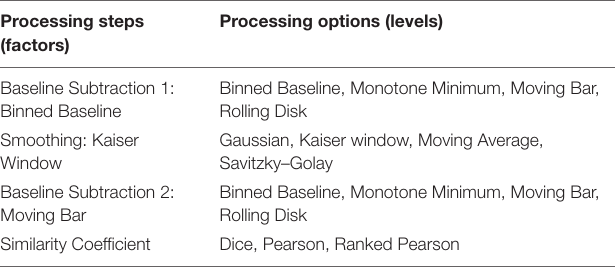
TABLE 2 | (A) Factors and levels used in the designed experiments for processing MALDI-TOF MS spectra of the C. jejuni collection. Processing steps